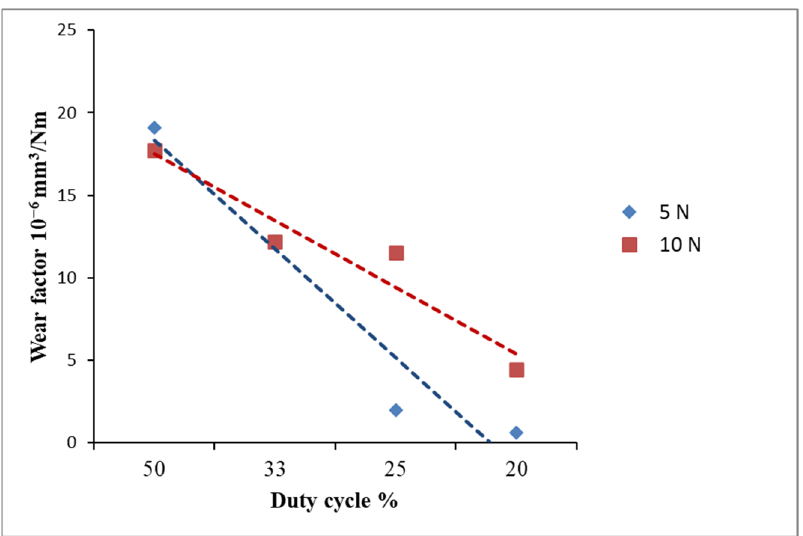
Figure 5. Wear factor as a function of applied duty